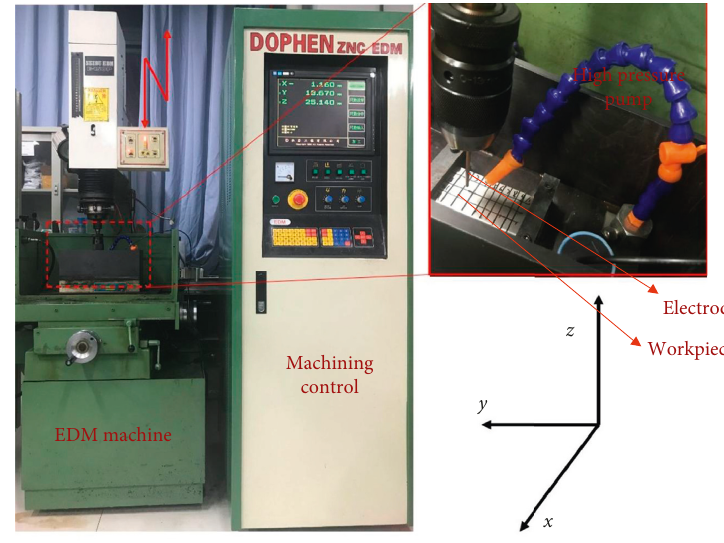
Figure 1: Photograph of the experimental setup.